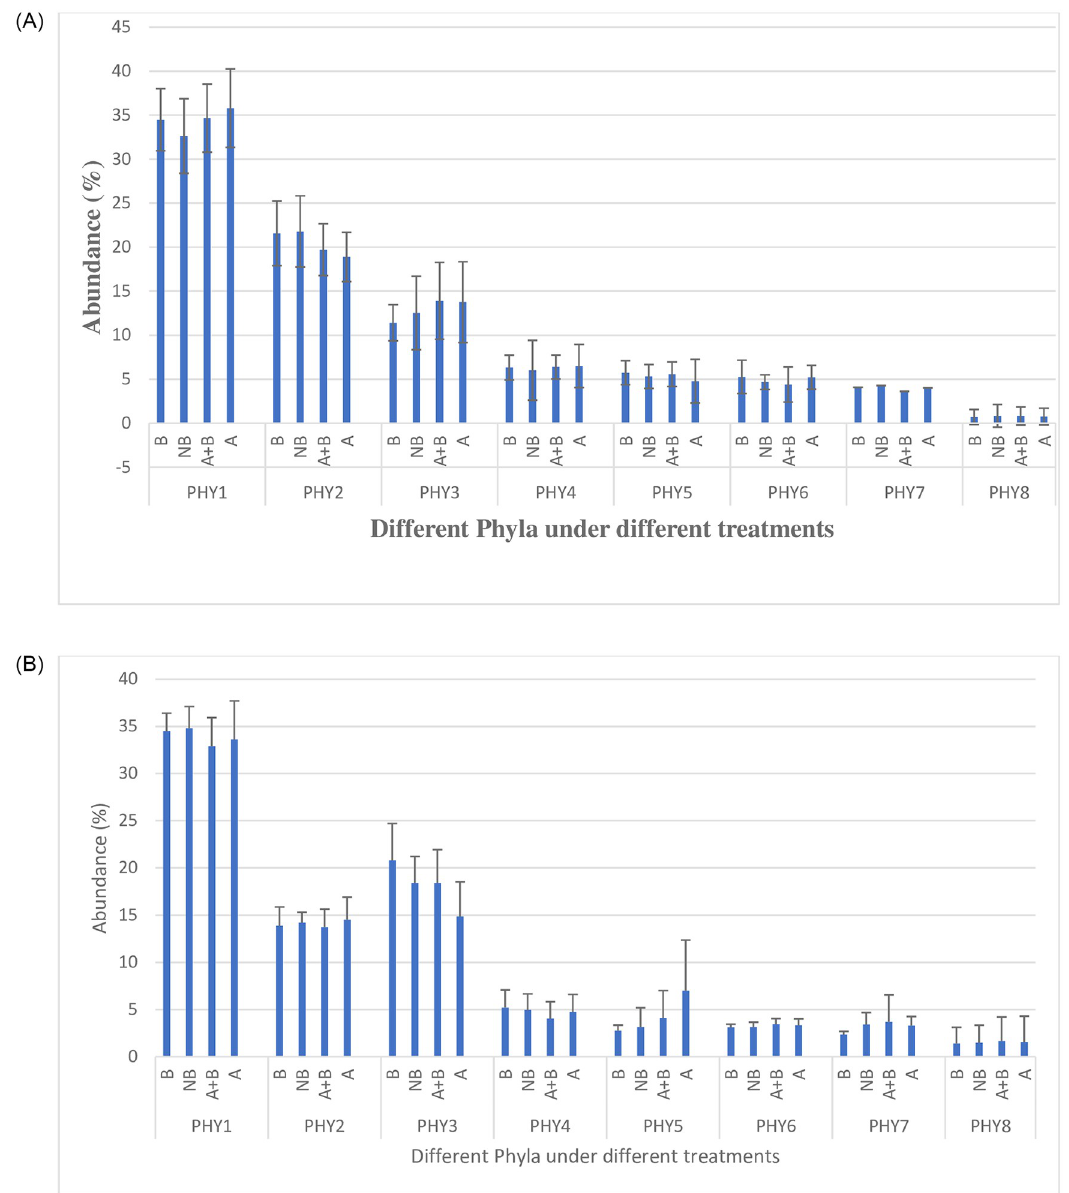
Fig 1. A: Proportion of major bacterial phyla found in the four soil treatment samples obtained from Kabale district. B- Beans Only, NBA- No Beans and Artemisia , N+B- Beans and Artemisia and A- Artemisia Only (B and NBA-bulk soil, A+B and A- rhizospheric soil). PHY1- Proteobacteria, PHY2- Acidobacteria, PHY3- Actinobacteria, PHY4- Bacteroidetes, PHY5- Verrucomicrobia, PHY6-Gemmatimonadetes, PHY7- Firmicutes, PHY8- Others. B: Proportion of major bacterial phyla found in the four soil treatment samples obtained from Kabarole district. B- Beans Only, NBA- No Beans and Artemisia , N+B- Beans and Artemisia and A- Artemisia Only (B and NBA-bulk soil, A+B and A- rhizospheric soil). PHY1- Proteobacteria, PHY2- Acidobacteria, PHY3- Actinobacteria, PHY4- Bacteroidetes, PHY5- Verrucomicrobia, PHY6-Gemmatimonadetes, PHY7- Firmicutes, PHY8- Others.